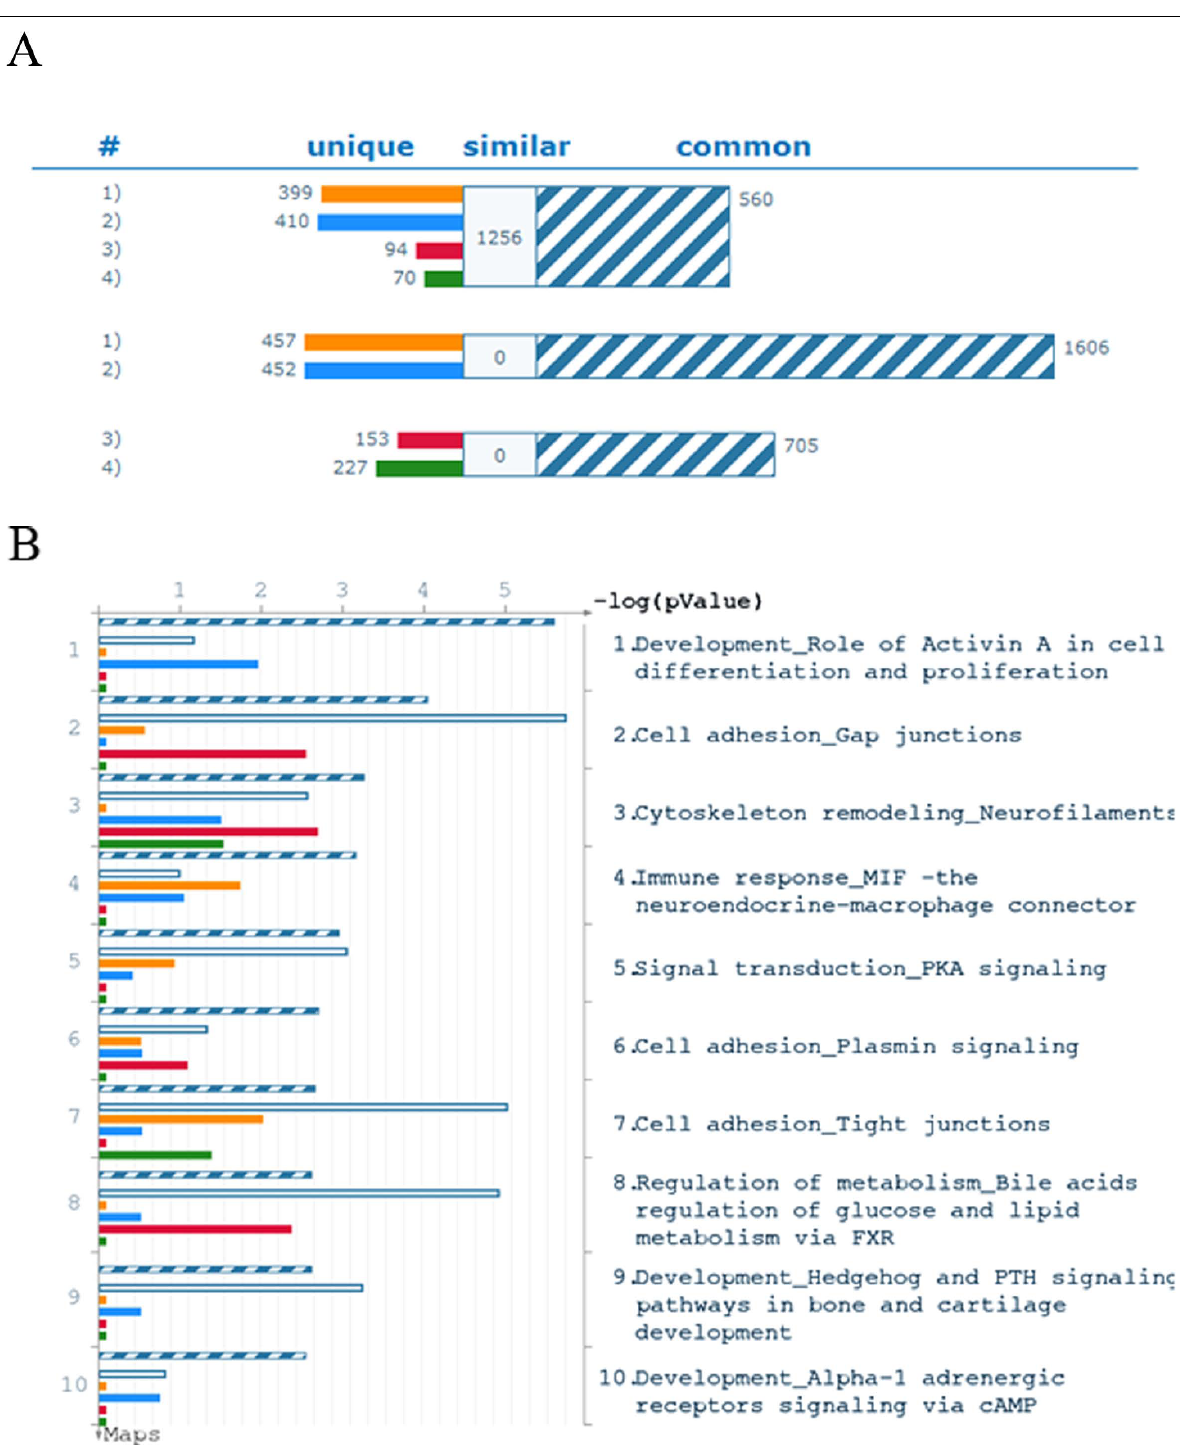
Figure 2 Comparison of gene expression and GeneGo canonical pathway maps among T3/HDF, T3/CMHDF, T3/MEF and T3/CMMEF cells . A. Parameters for comparison are set at threshold of 3 with p-value of 0.05. The common genes are indicated by blue/white strips. The white area denotes similar genes in which three of four are the same. The unique genes are marked as color bands: 1) T3/HDF, orange; 2) T3/CMHDF, blue; 3) T5/MEF, red; 4) T3/CMMEF, green. B. The top 10 GeneGo canonical pathway